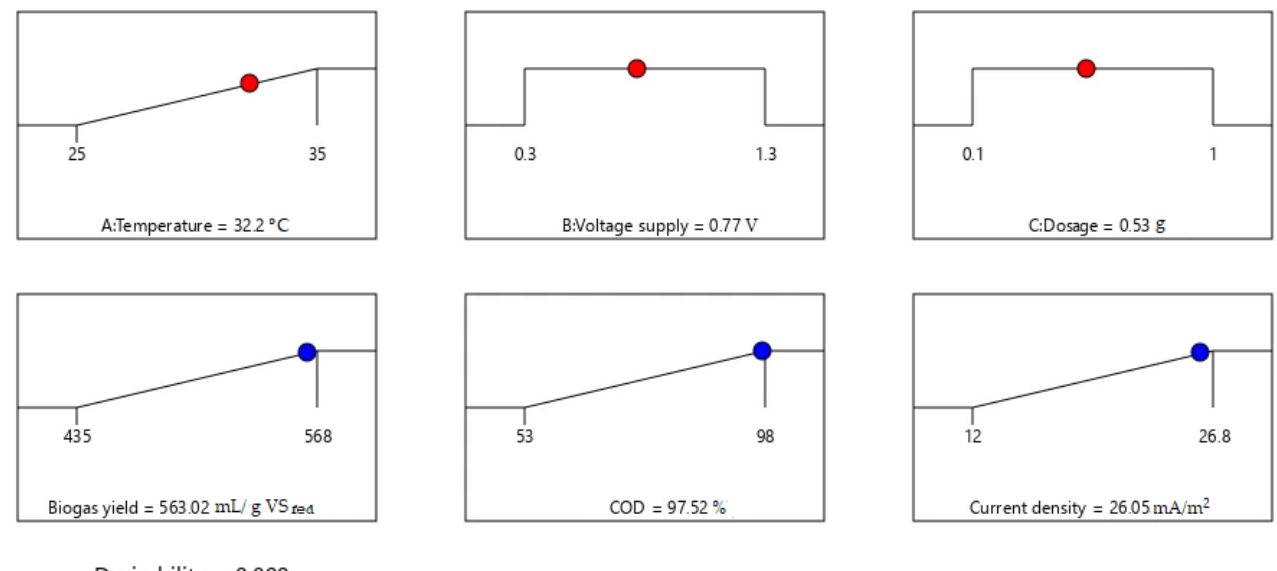
Figure 6. Ramp graphs of optimized process variables for the investigated responses.